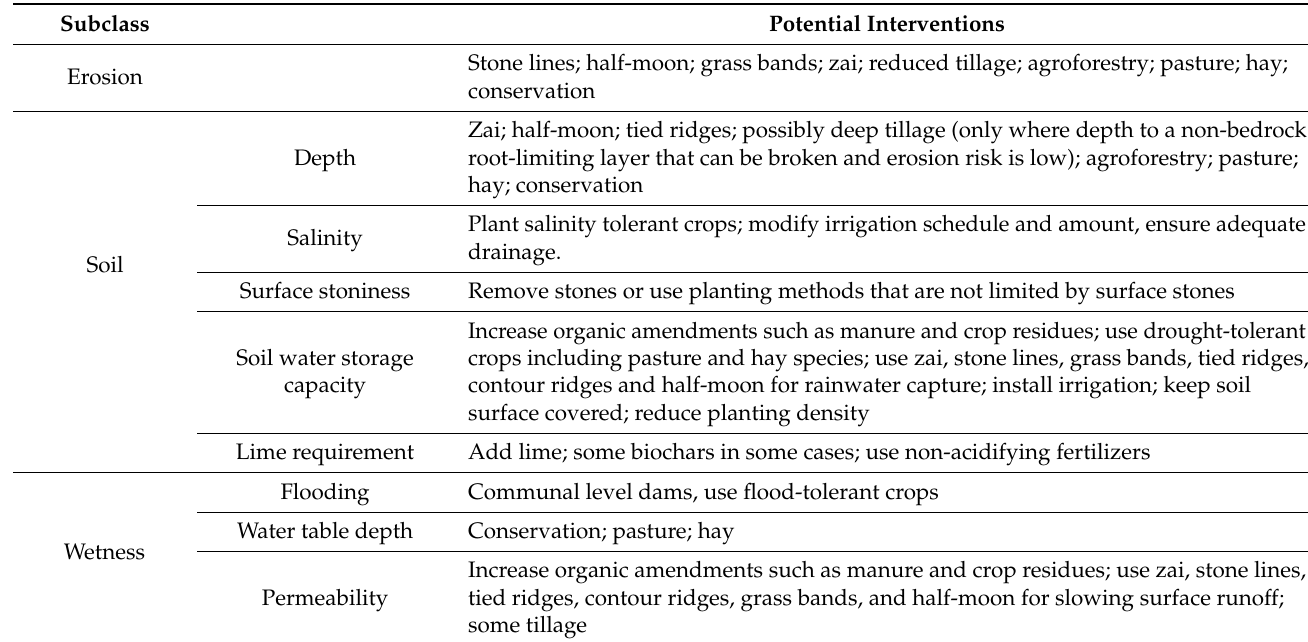
Table 2. Land capability classification subclass limitations and possible interventions. For more interventions, see www. wocat.net (accessed on 23 January